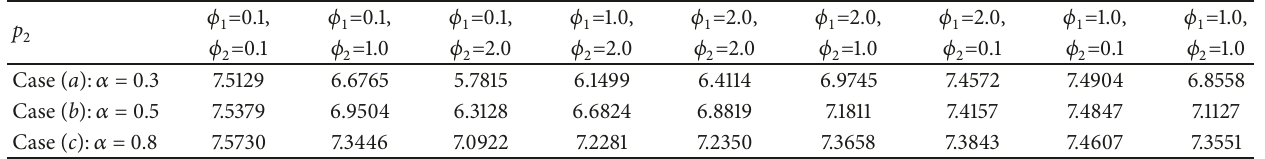
Table 2: The impact of fairness concern on player 2’s price p 2 under three